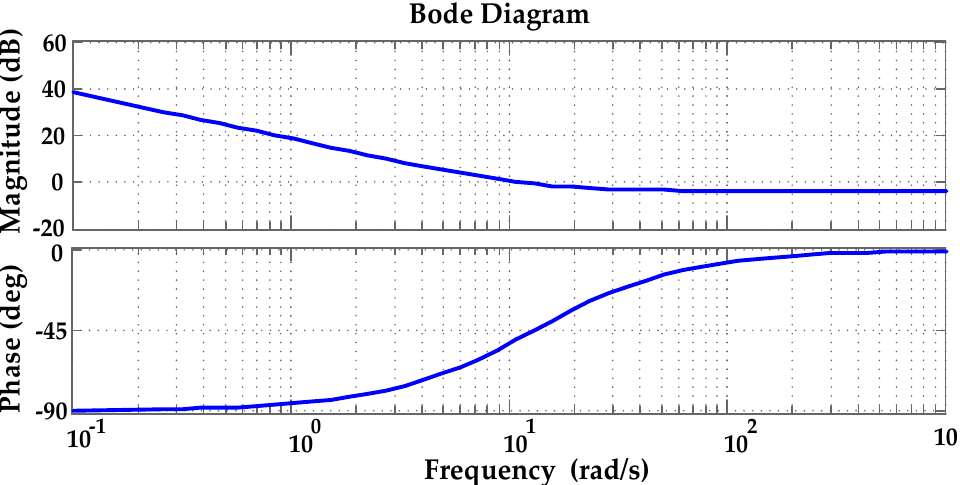
Figure 3. Bode plot of the MFI DC-link voltage proportional–integral (PI) controller.